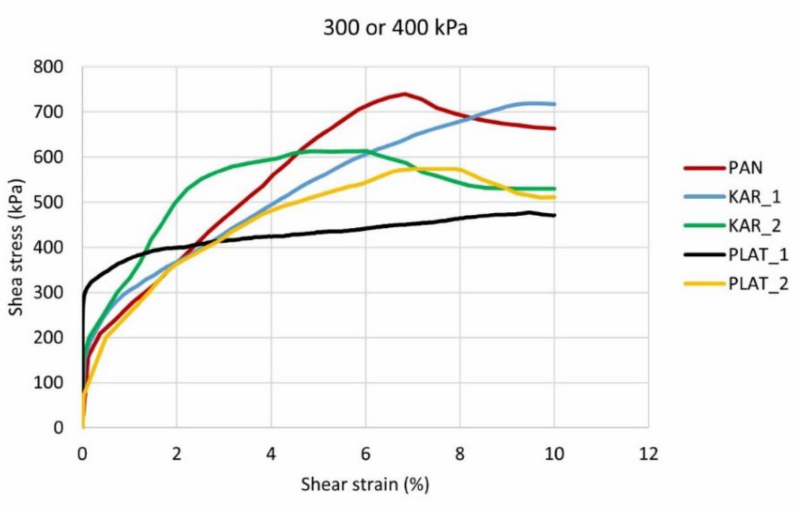
Figure 6. Typical dilatant behavior of the dense dry flysch